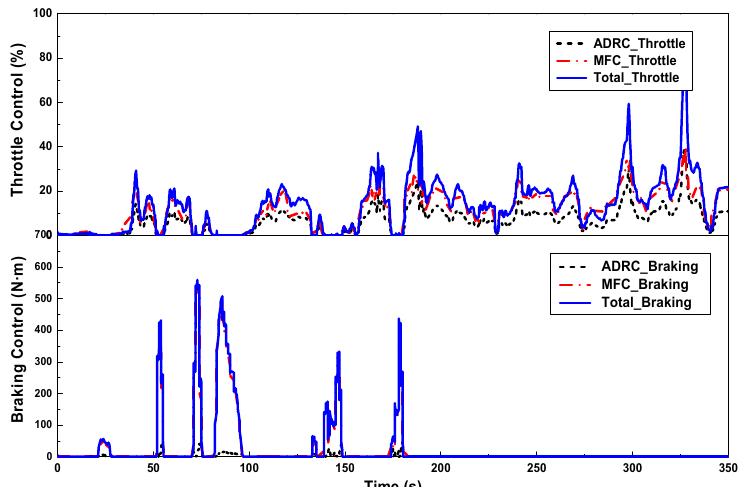
Figure 8. Comparison of the control output between active disturbance rejection control (ADRC) and the model-based feedforward controller